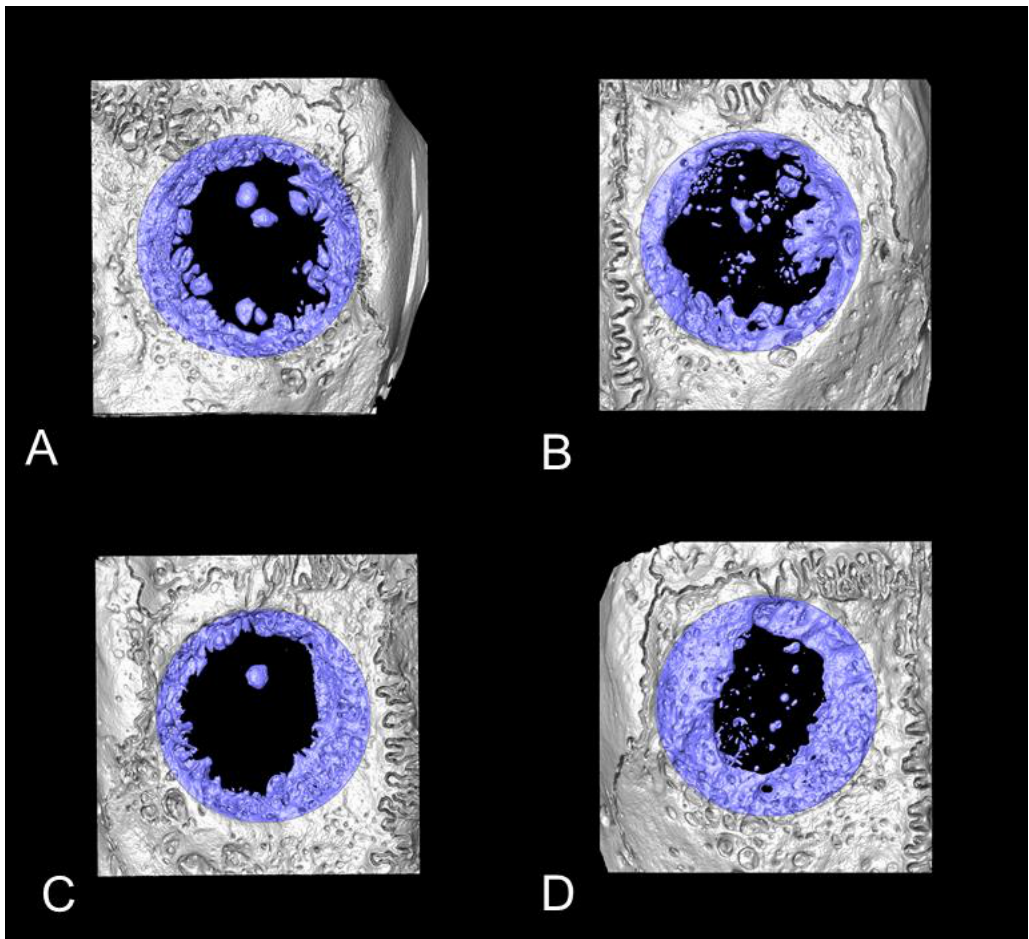
Figure 4. The micro-CT images of each group (top view). ( A ); CM supported bone formation from defect boarder. ( B ); mCM induced not only bone ingrowth from defect border, but also lots of small island-like newly formed bone in the middle of defect. ( C ); CM/M is showing similar bone formation from defect border as CM group. However, collagen barrier membrane did not promote additional bone formation. ( D ) mCM/M is demonstrating greater bone formation from defect border compared to mCM.